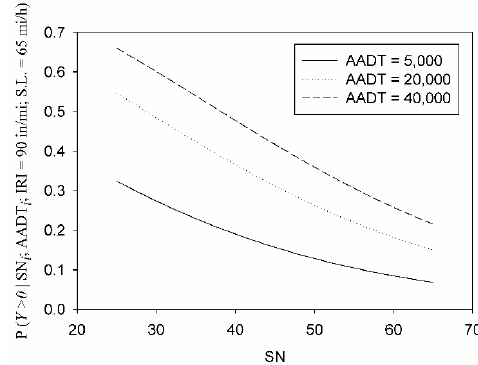
Figure 8. Probability mass function using fitted general model parameters for varying SN; ( a ) 20,000 AADT and ( b ) 40,000 AADT; and fixed IRI and SL.